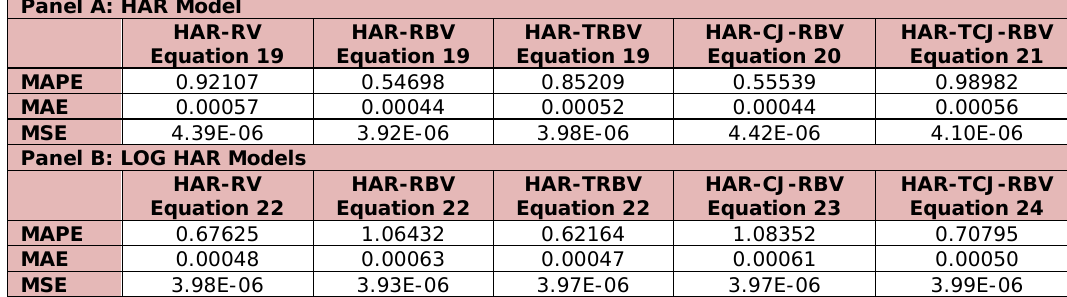
Table 4: “Out-of-Sample Prediction Accuracy”. Source: Own